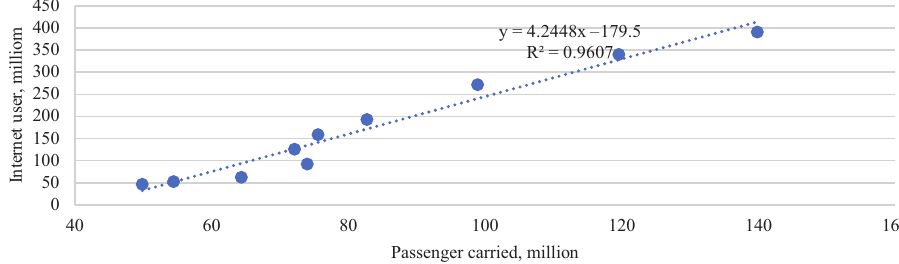
Figure 7. Regression result of passenger carried in India from 2008 to 2017 Table 5. Regression analysis of registered carrier departures in four sample countries from 2008 to 2017